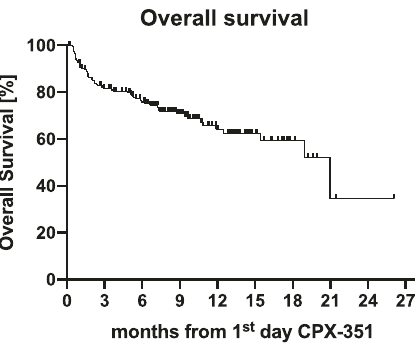
Fig. 2 Overall (OS) of the entire cohort. After a median follow-up of 9.3 months (range: 0.2 – 26.1 months) median OS of the entire cohort ( n = 188) was 21 months and estimated 2-year OS was 35%. OS for the entire cohort was calculated as the time from the fi rst day of treatment with CPX-351 to death from any cause or last follow-up in